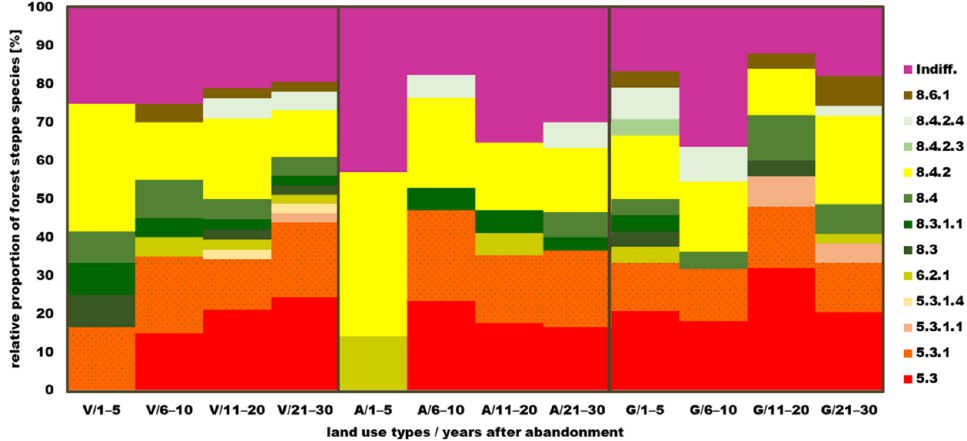
Figure 7. Relative proportion of coenosystamatical groups of forest steppe species in different age groups of abandoned lands (V—vineyards, A—arable land, G—grasslands, Indiff.—indifferent, 8.6.1— Prunetalia spinosae , 8.4.2.4— Quercion petraeae-cerris , 8.4.2.3— Aceri tatarico-Quercion , 8.4.2— Quercetalia pubescentis-petraeae , 8.4— Querco-Fagetea , 8.3.1.1— Quercion robori-petraeae , 8.3— Quercetea robori-petraeae